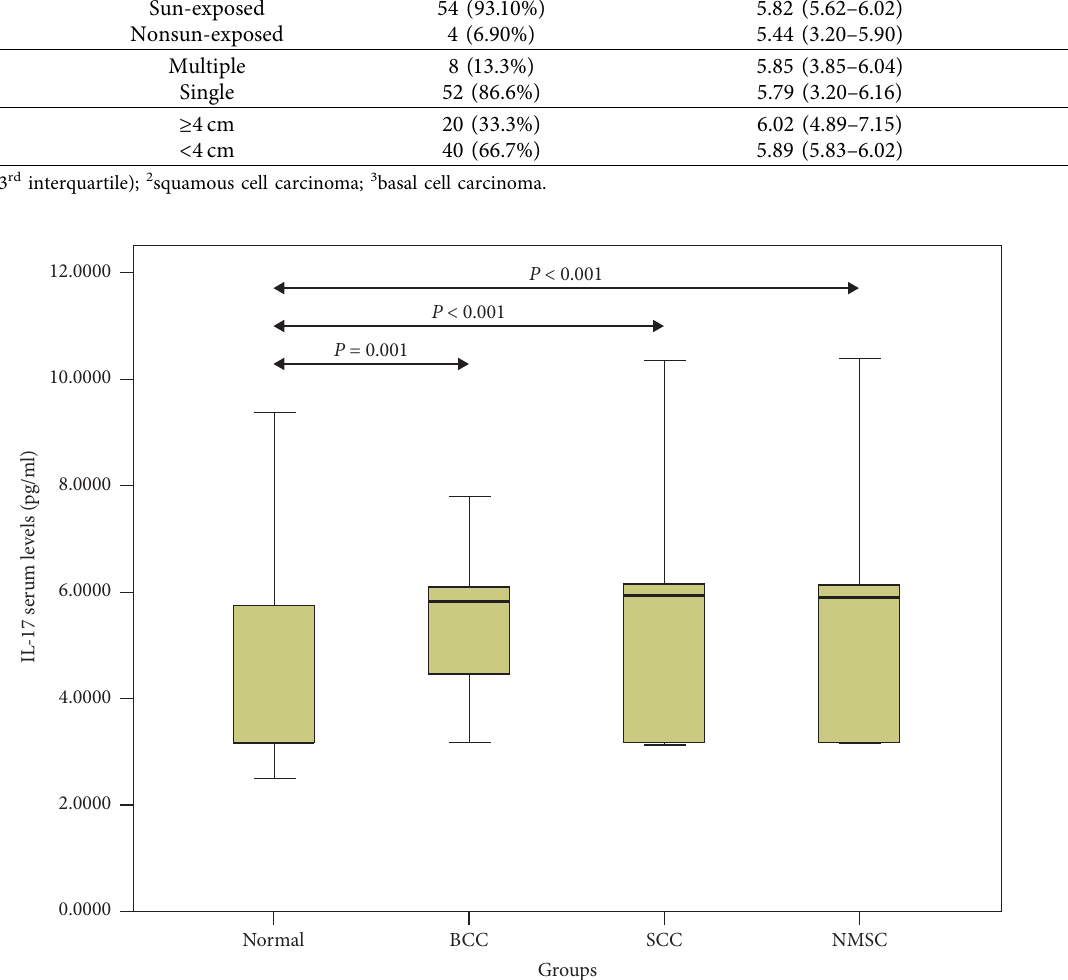
Figure 1: Box plot of IL-17 serum levels. The middle line represents the median. The ends of the boxes represent lower and upper quartiles and the ends of the whiskers represent the minimum and maximum. BCC, basal cell carcinoma; NMSC, nonmelanoma skin cancer; SCC, squamous cell